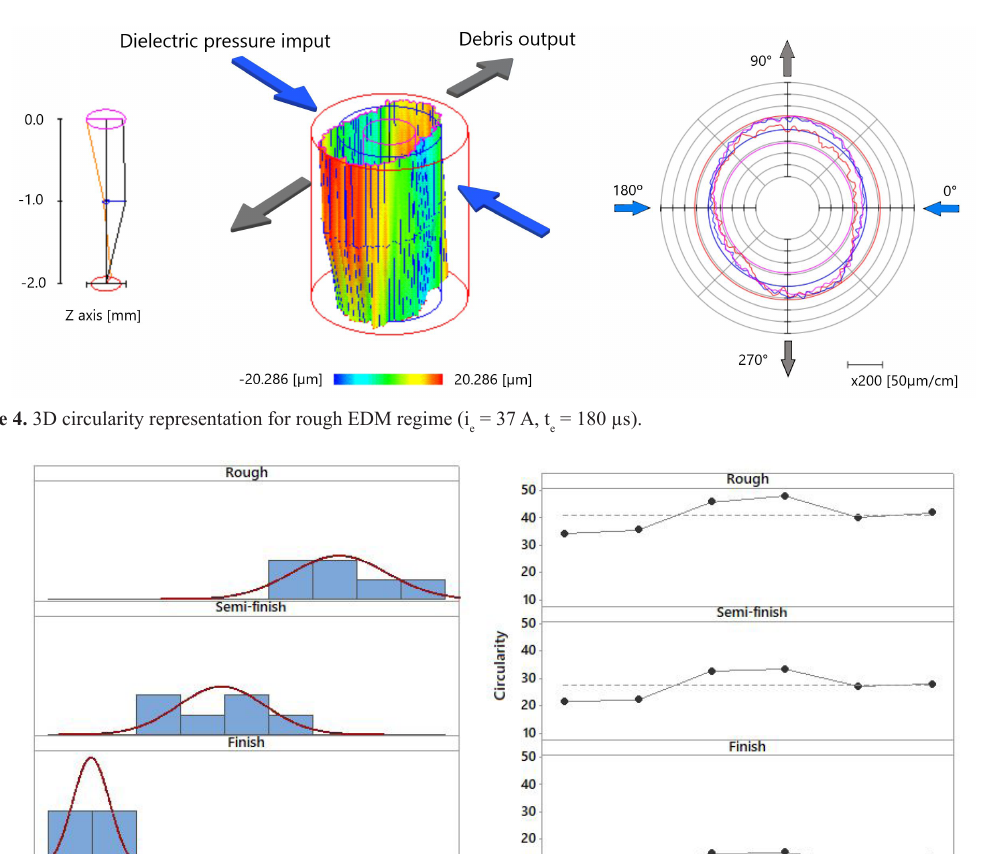
= 11 A, t = 56 µs) and finish regimes e e